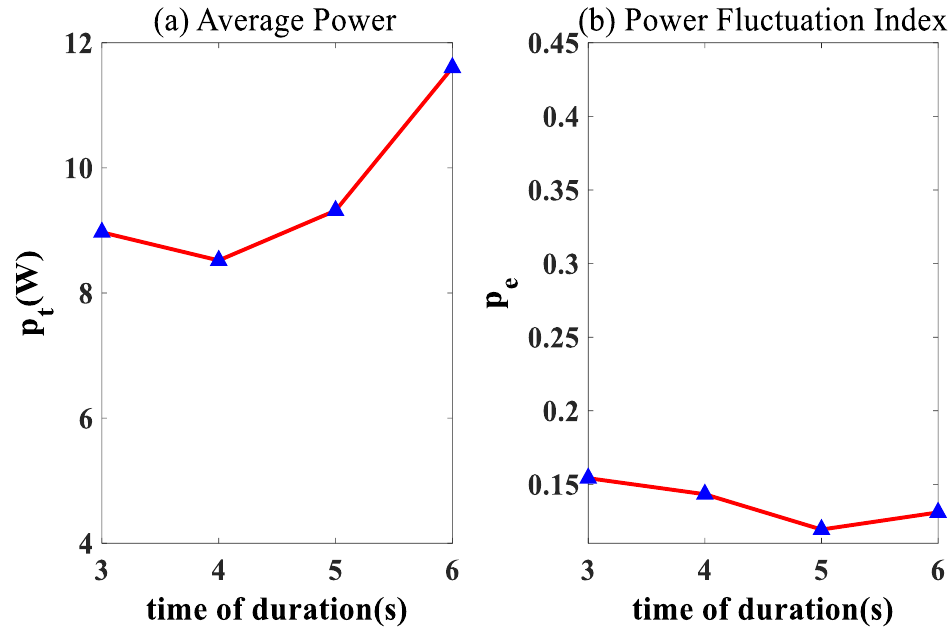
Figure 17. The average output power and power fluctuation index under different open state durations (trigger pressure is 4.0 MPa).